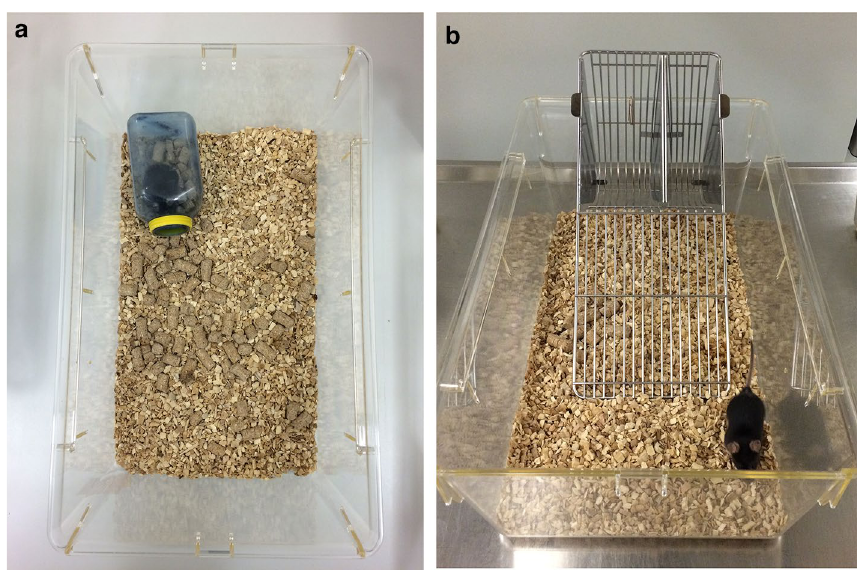
Figure 3. Testing cage. A Polysulfone type III cage was used to test burrowing behavior ( a ) and trait anxiety- related behavior in the free exploratory paradigm ( b ). Note that the gridded cage lid with water bottle and food pellets was removed for the image ( a ). When the mice habituated to the testing cage and burrowing behavior was monitored, the cage was closed by a gridded lid. For the free exploratory paradigm, the lid was